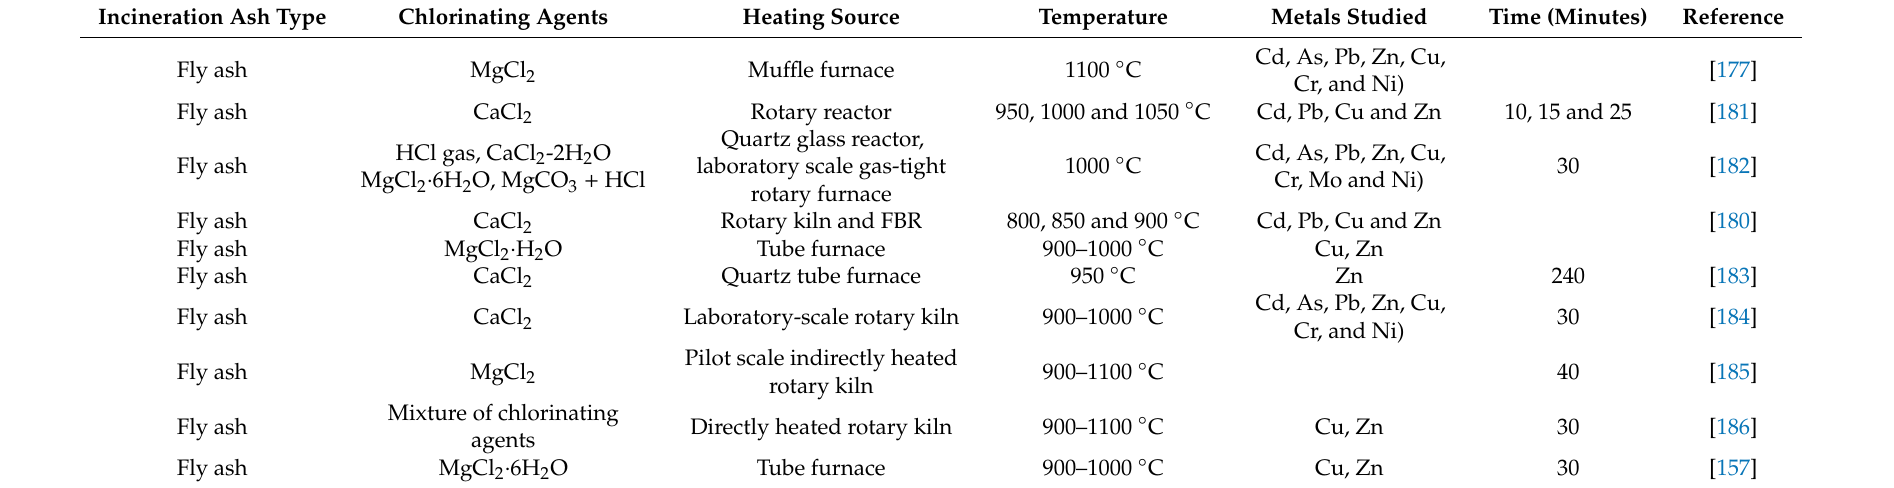
Table 7. Overview of previous studies and their experimental parameters for the removal of heavy metals from fly